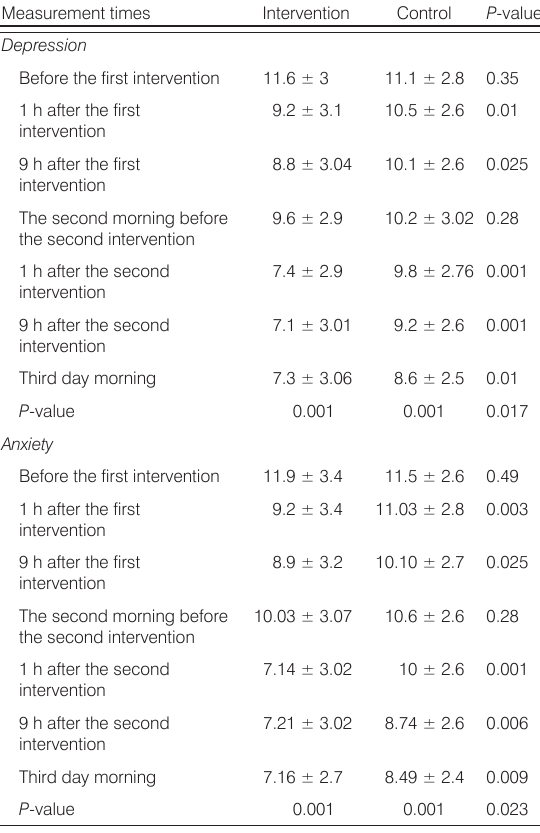
Table 2. Comparison of depression and anxiety in the intervention and control groups before and after the intervention.